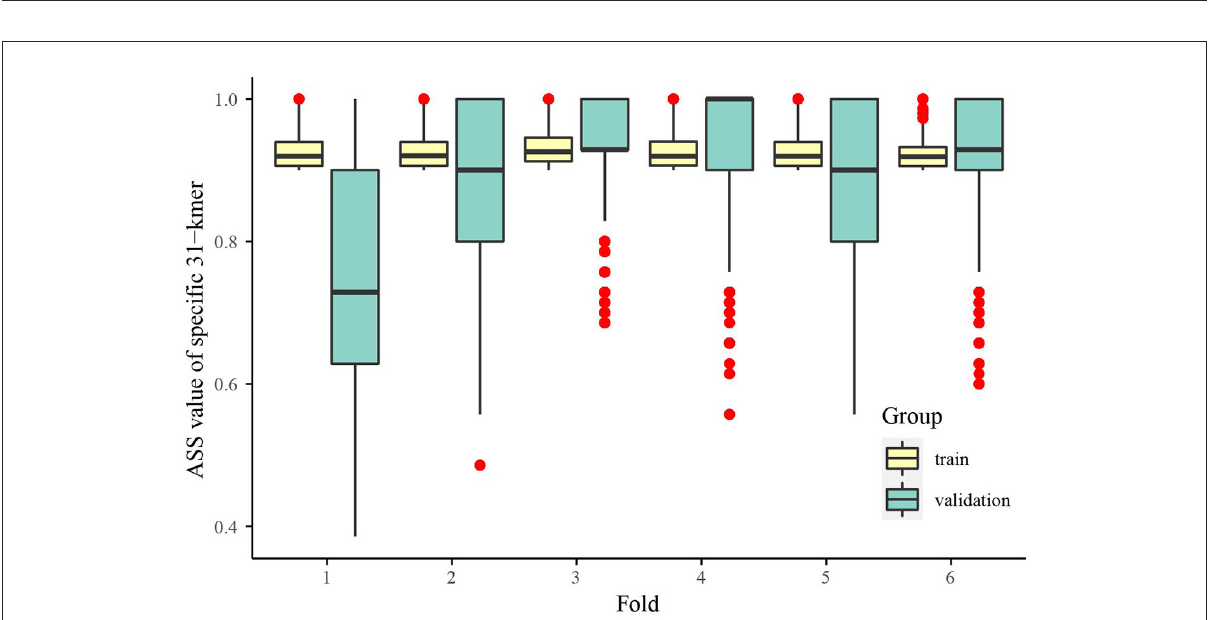
FIGURE4 Boxplot of ASS value of HV08-specific 31-mers in 6-fold LOOCV. In each fold, even fold one, the k -mers obtained from training data maintain a high level (the average ASS is higher than 0.7, with most 0.85) of ASS in validation data, which means that these k -mers could effectively identify